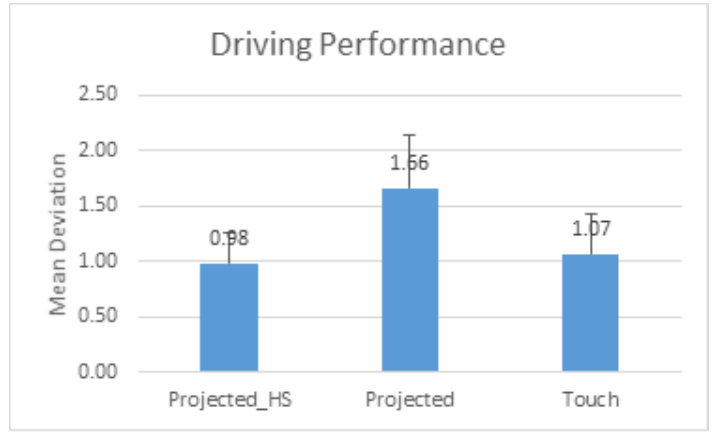
Figure 26. Comparing Driving Performance in terms of mean deviation.